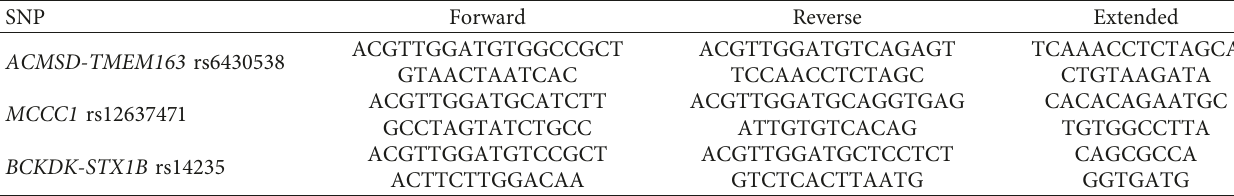
Table 1: Sequences of primers used for genotyping in this